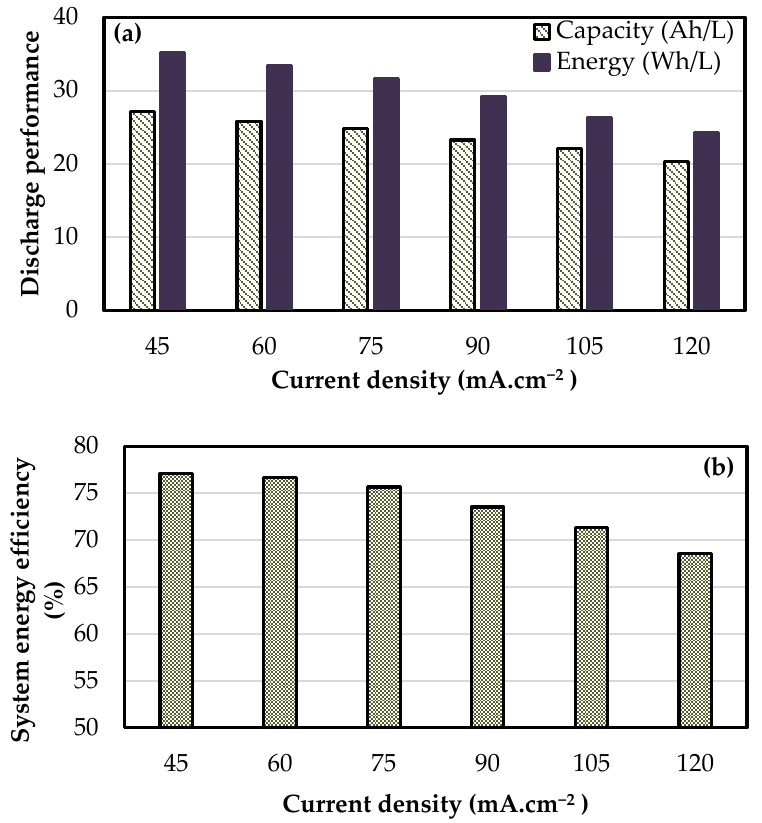
Figure 8. Electrochemical performance of 8 cell—918 cm 2 stack at different current densities at a constant electrolyte flow rate of 0.36 mL.min − 1 .cm − 2 : ( a ) discharge capacity and energy density and ( b ) system energy efficiency.